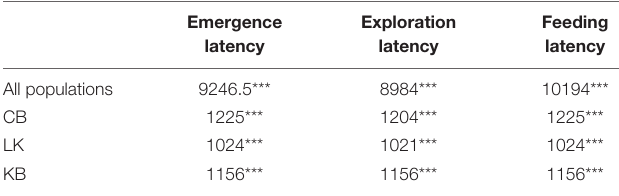
TABLE 4 | Results from pairwise comparisons (Wilcoxon Rank sum test with continuity corrections) of behavior between trial 2 and last trial, indicating habituation and